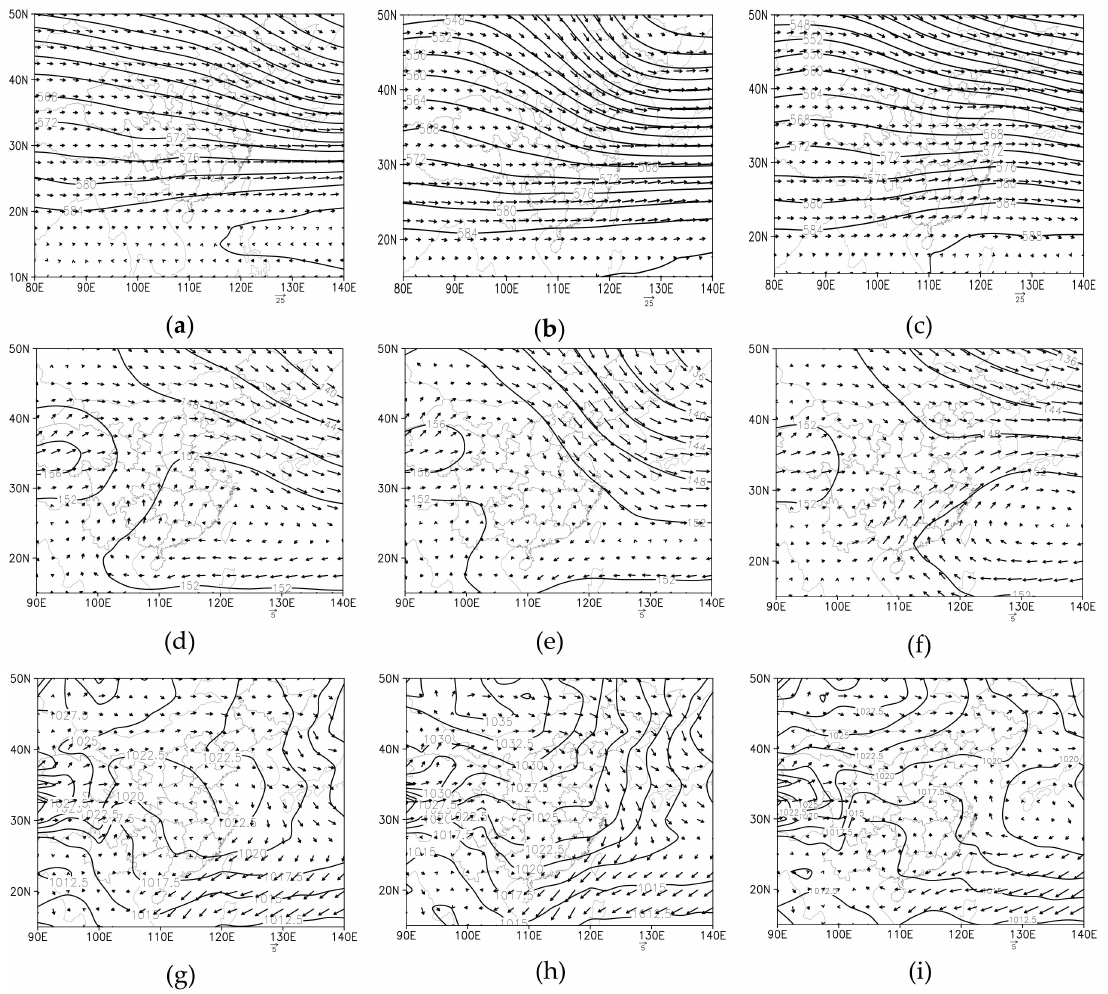
Figure 2. The synoptic situation for each type: equalized pressure (EQP: ( a , d , g )), advancing edge of a cold front (ACF: ( b , e , h )), inverted trough of low pressure (INT: ( c , f , i )); 500 hPa ( a–c ), 850 hPa ( d–f ) and SLP ( g–i ). Among them, contours were pressure field (unit: hPa) and vectors were wind field (unit: m s − 1